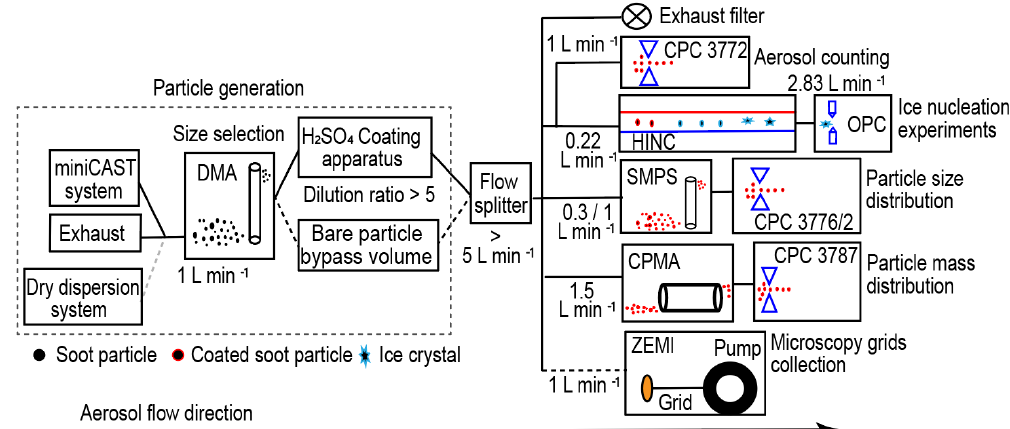
Figure 1. Schematic of the experimental set-up. miniCAST: miniature Combustion Aerosol Standard; DMA: differential mobility analyser; CPC: condensation particle counter; HINC: horizontal ice nucleation chamber; OPC: optical particle counter; SMPS: scanning mobility particle sizer; CPMA: centrifugal particle mass analyser; ZEMI: Zurich Electron Microscope Impactor.